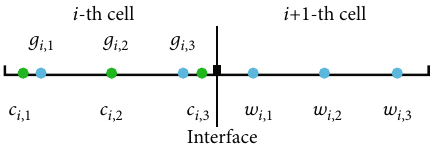
Figure 4: 1D grid, di ff erent solution points and ghost